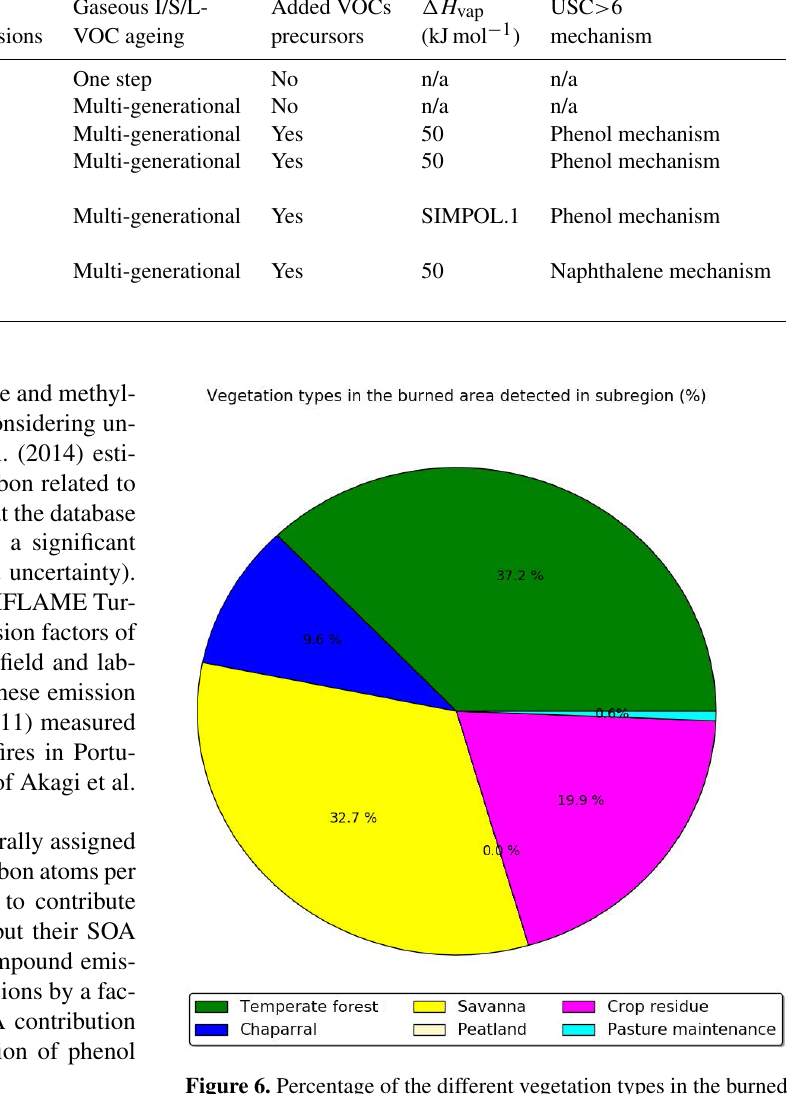
Table 1. Summary of the sensitivity simulations performed by Polyphemus (n/a: not applicable). Simulations Wildfires Gaseous